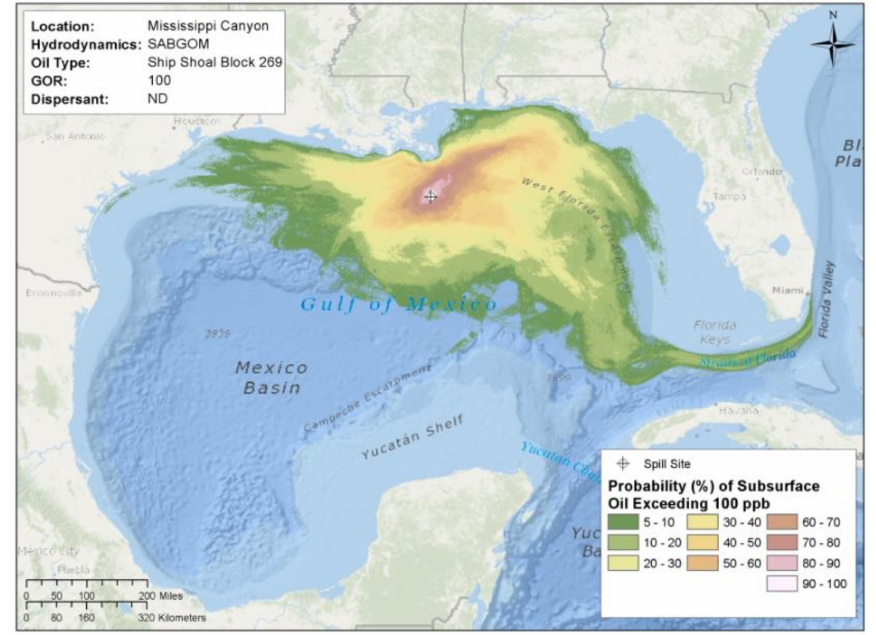
Figure 4. Example map of the probability of subsurface total hydrocarbon concentration exceeding 100 part per billion (ppb) (from